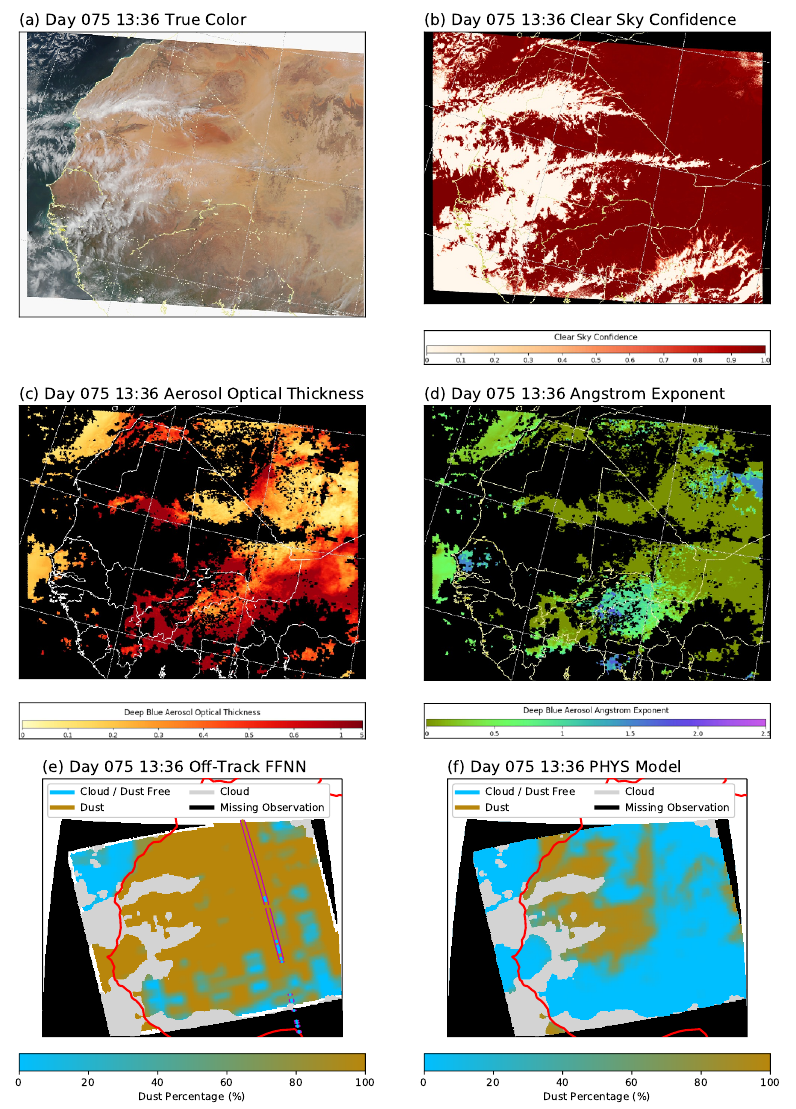
Figure 11. A case study over Arabian peninsular on day 075, at 13:36. ( a – d ) depict images from Wisconsin’s VIIRS quicklook, where ( a ) represents the true color, ( b ) Clear Sky confidence, ( c ) Aerosol Optical Thickness, and ( d ) Angström Exponent; ( e ) FFNN results on the same geolocation. Results are plotted in a 0.1 × 0.1 latitude and longitude grid, and the percentage of dust within the grid are shown as colors. Thin magenta lines show the CALIOP swath of this region. Pixels within the magenta lines are the CALIOP product; ( f ) same as ( e ), but for PHYS